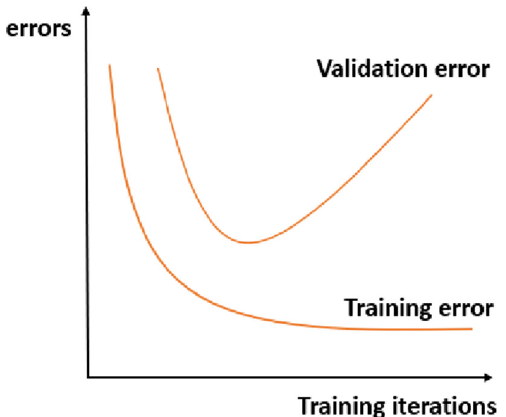
Fig. 13 Overfitting in deep learning